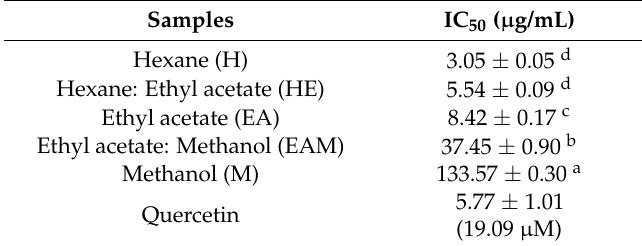
Table 1. The half maximal inhibitory concentration (IC 50 ) of α -glucosidase inhibitory activity of C. nutans leaves